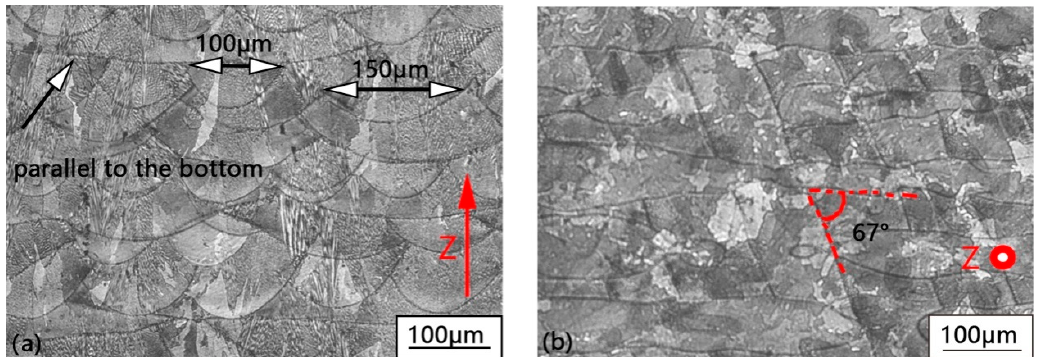
Figure 2. The macrostructure of selective laser melted (SLMed) sample observed by the optical microscope (OM). ( a ) The magnification of XZ section ( b ) The magnification of XY section.